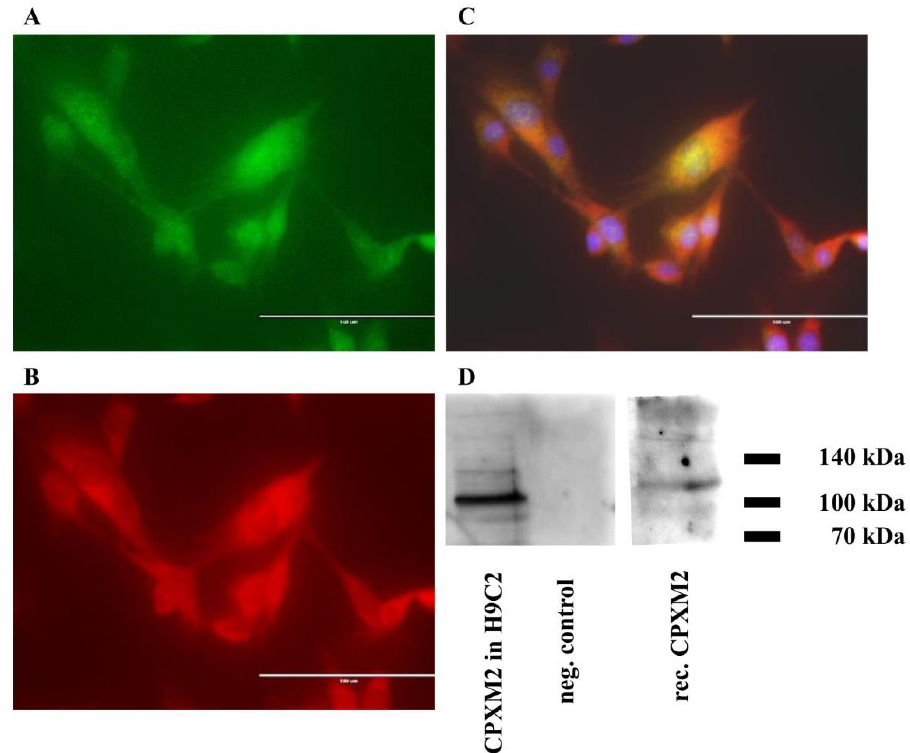
Figure 2. Expression of CPXM2 and Pdlim3 in rat cardiomyocytes. H9C2 cells were fixed and double-labelled for confocal indirect immunofluorescence microscopy with the polyclonal ( A ) anti-CPXM2 and ( B ) anti-Pdlim3 antibodies. In the overlay image ( C ) intracellular co-localisation of CPXM2 and Pdlim3 in rat cardiomyocytes is depicted. Nuclear DNA was stained with DAPI (shown in blue). In ( D ) the CPXM2 protein expression in H9C2 as well as a positive control (human recombinant CPXM2) and negative control (empty well) are shown. Bar = 100 µ